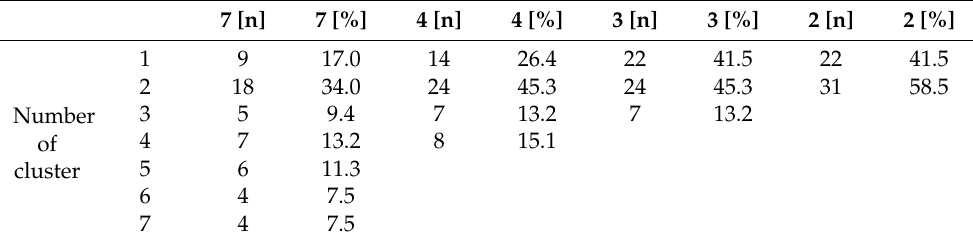
Table 7. Population of individual